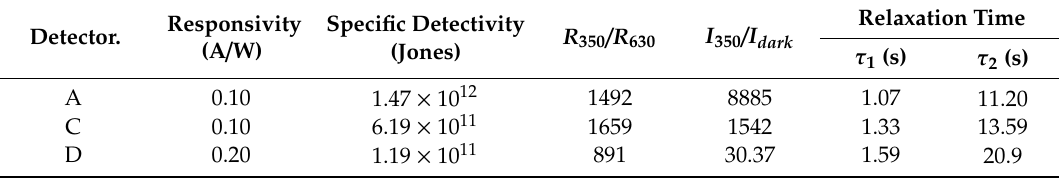
Table 2. The key detector parameters extracted from detector A, C and D. The responsivity, specific detectivity and relaxation time are obtained at − 3 V under the 350 nm